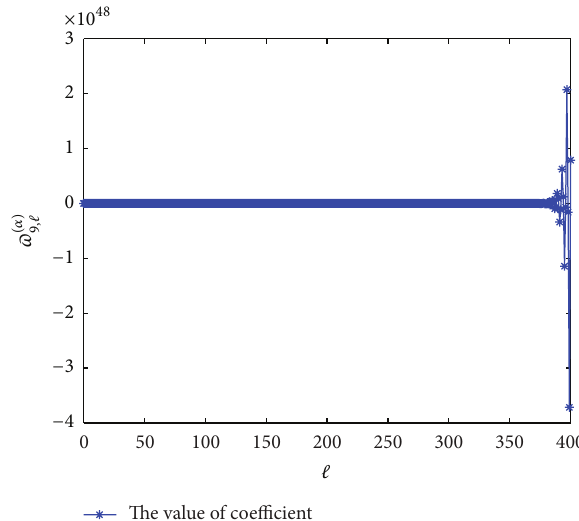
Figure 8: The values of the coefficients 𝜛 (𝛼) 10,ℓ (ℓ = 0,1,...) for 𝛼 = 0.3 .